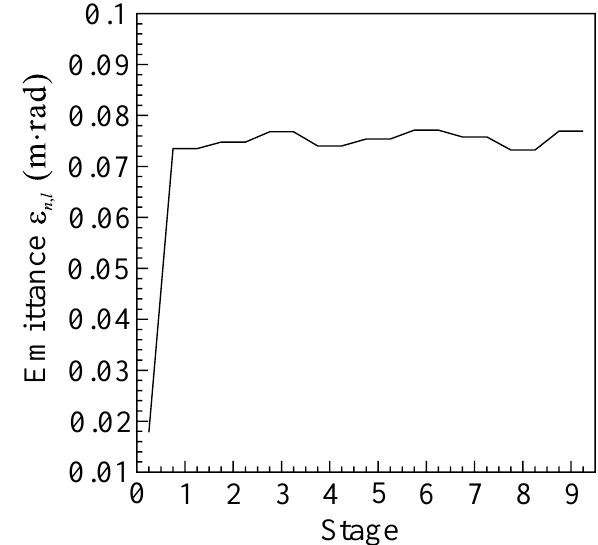
FIG. 3. (Color) The angles of the electron beams.